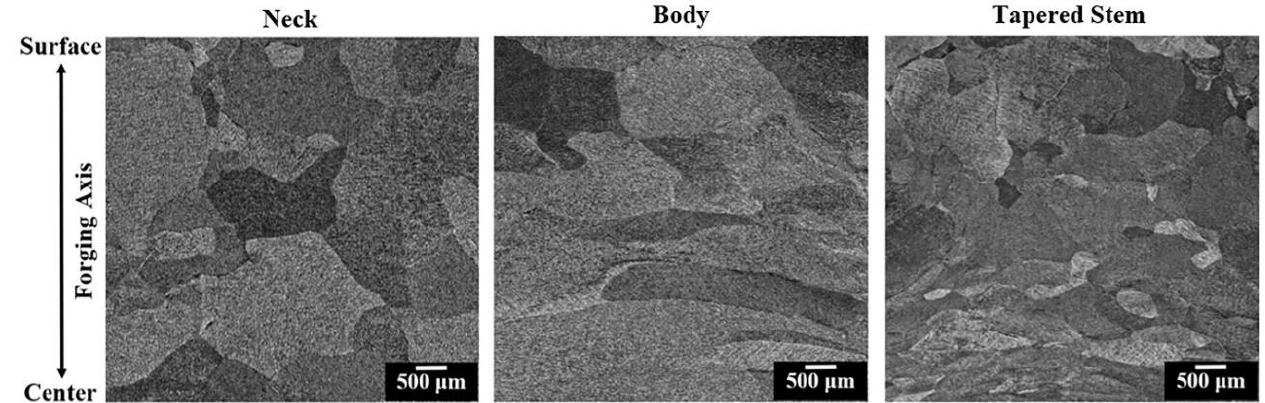
Figure 9. Digital micrograph of the martensite at the different locations of the DPF femoral stem.